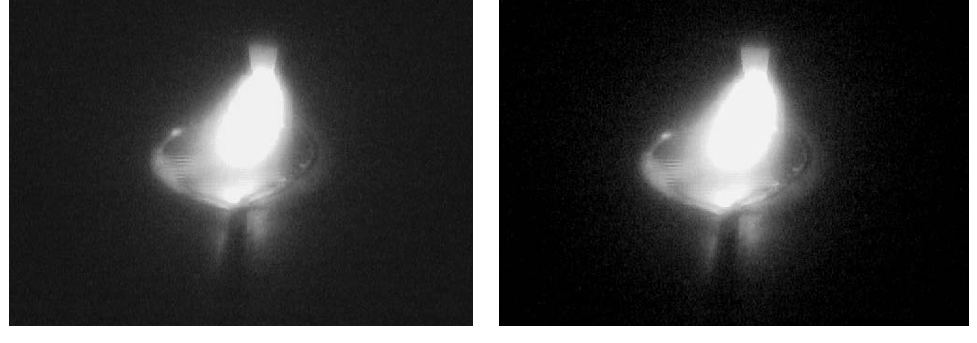
Fig. 6 Procession result of median filtering and gray